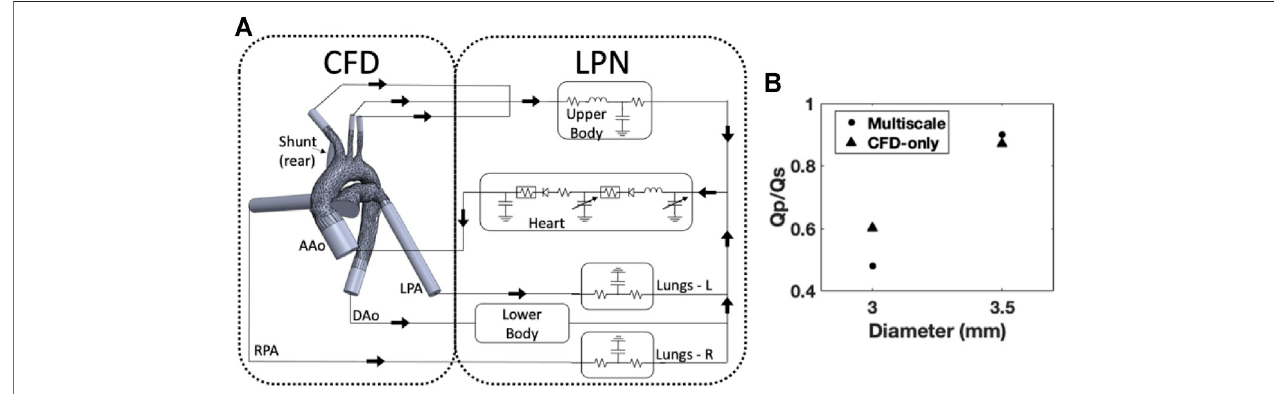
FIGURE 8 | (A) Schematic of the multiscale model, the LPN is simpli fi ed for illustrative purposes; (B) The effect of diameter on the Qp/Qs ratio was reproduced for two datapoints using the multiscale model and showed similar results compared to the CFD-only